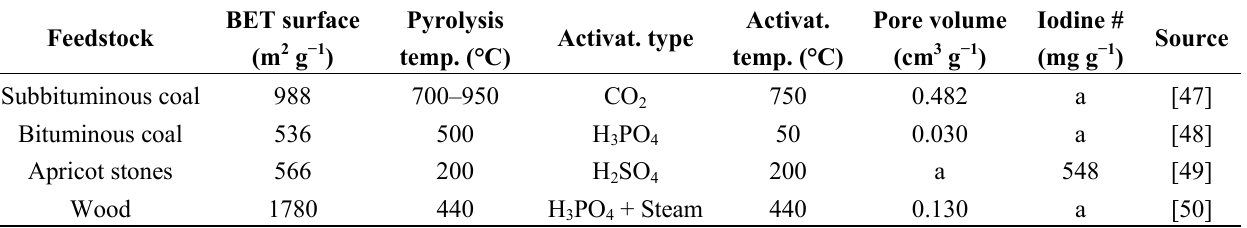
Table 5. Published BET surface areas of AC produced from fossil coal and biomass feedstocks. BET surface Feedstock temp. (°C) Subbituminous